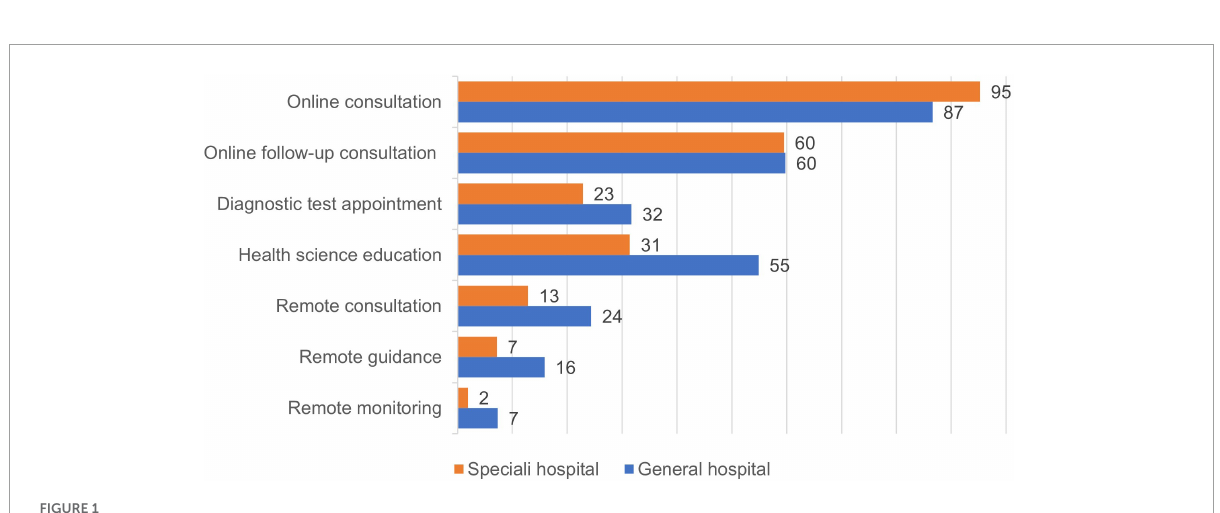
FIGURE1 Internet hospital services provided by 292 pediatricians